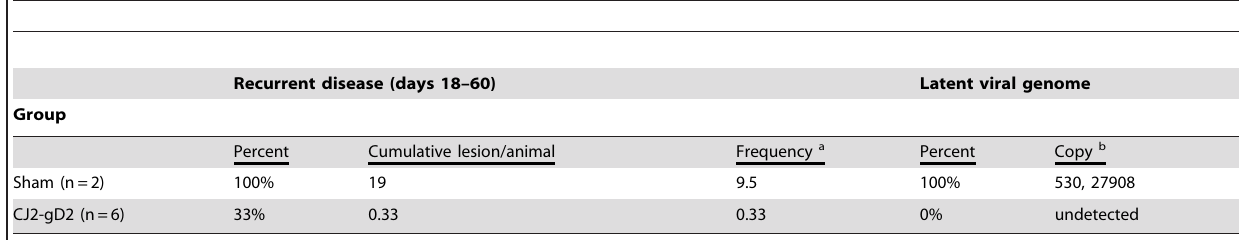
sham-immunized with DMEM (n= 8, 8), immunized with freshly prepared gD2-alum/MPL (n= 8, 6), or immunized with CJ2-gD2 (n= 8, 6). The neutralizing antibody titers detected in the CJ2- gD2-immunized animals are 5.5- and , 8-fold higher than those Fig. 2A represents the combined results from two independent detected in the gD2-alum/MPL-immunized animals after the experiments, in which two sets of female Hartley guinea pigs were second and third immunizations, respectively (p , 0.0001). Again, Table 1. Immunization with CJ2-gD2 is highly effective in protecting against recurrent HSV-2 genital disease and the establishment of latent